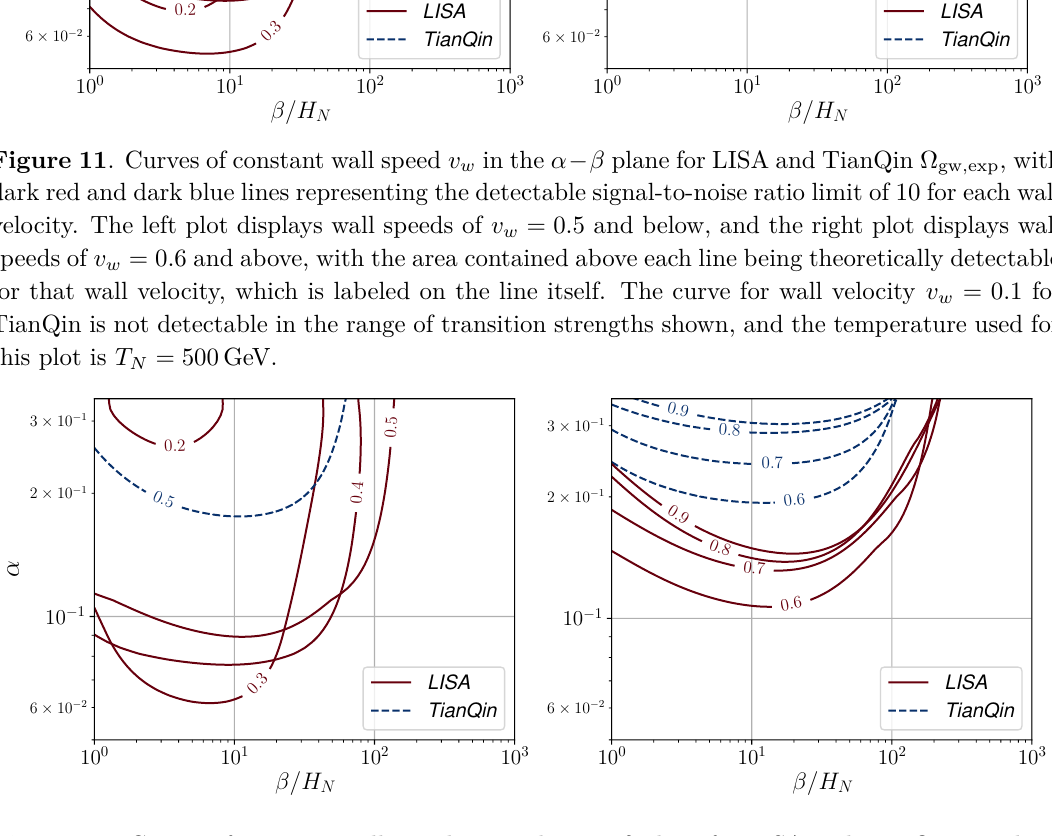
Figure 12 . Curves of constant wall speed v w in the α − β plane for LISA and TianQin matching figure 11, now with the suppression Σ applied giving Ω gw , with dark red and dark blue lines representing the detectable signal-to-noise ratio limit of 10 for each wall velocity. Once again the left plot displays wall speeds of v w = 0 . 5 and below, and the right plot displays wall speeds of v w = 0 . 6 and above with the temperature used for this plot being T N = 500